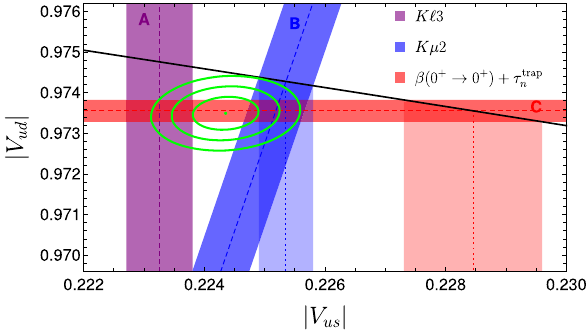
Fig. 6 Updated plot of Ref. [335] for the data in Eq. (23) in V us – V ud plane.The1 σ ,2 σ and3 σ contours(greencircles)ofthefitareintension with CKM unitarity (black solid curve). The projections on | V us | axis show the values | V us | B and | V us | C obtained from the unitarity